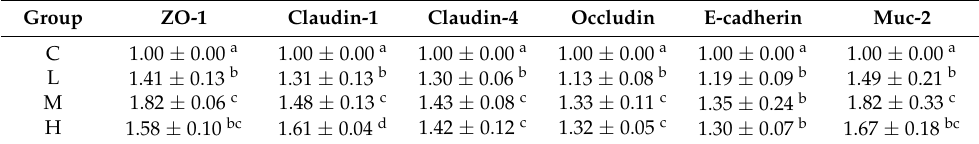
Table 5. Effects of FRJ on gene expression of mechanical barrier of